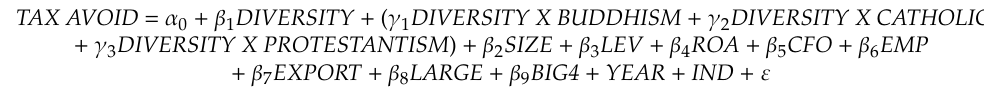
Table 3. The e ff ect of directors’ religious diversity on tax avoidance of